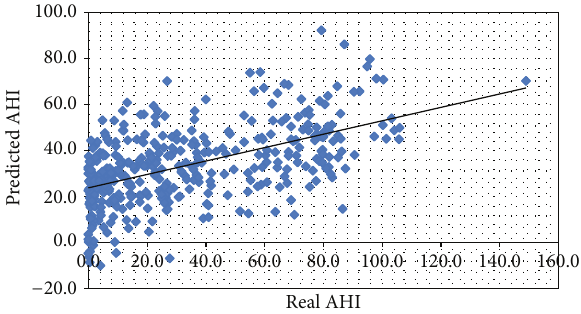
Figure 1: Distribution of predicted AHI values regarding real AHI